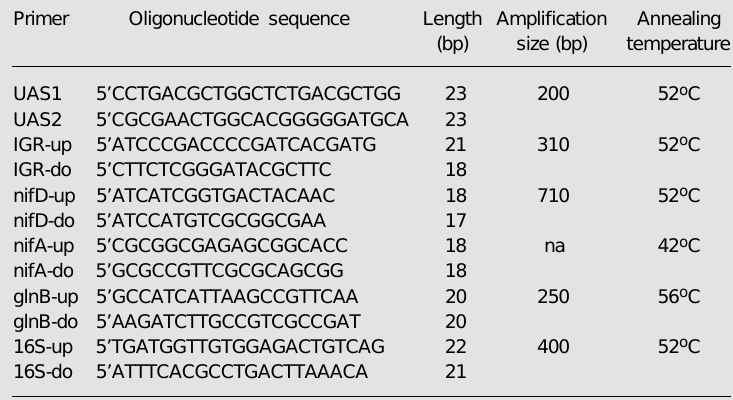
Table 2. Oligonucleotide primers.